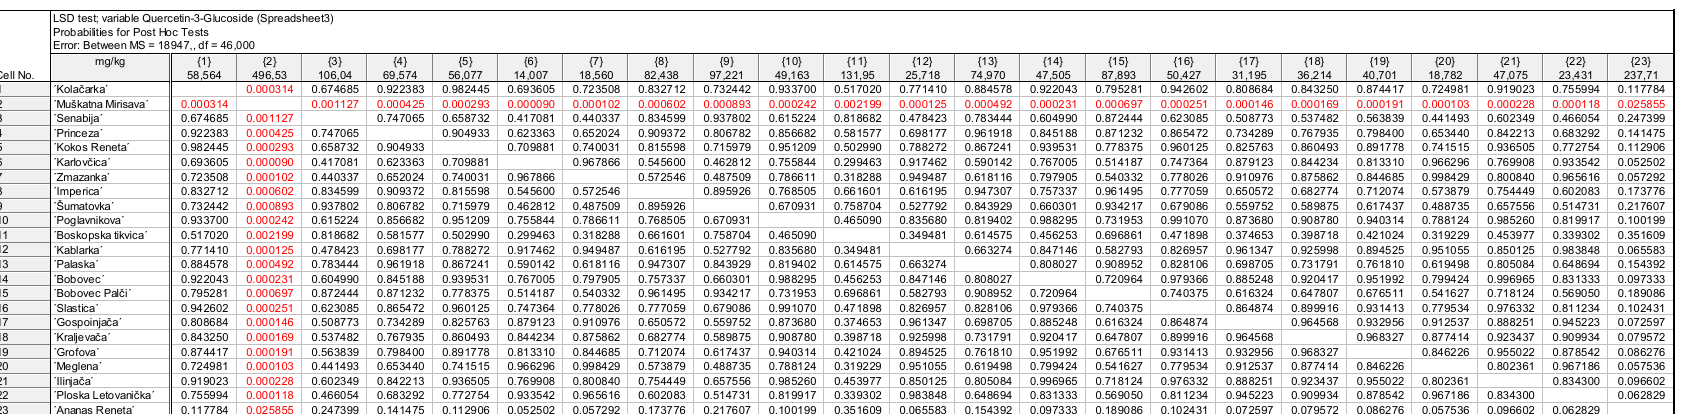
Figure A5. The statistical significance of quercetin-3-rutinoside in traditional apple varieties; the p -values of the correlations of identified polyphenols. Statistically significant p -values are marked red ( p < 0.05).